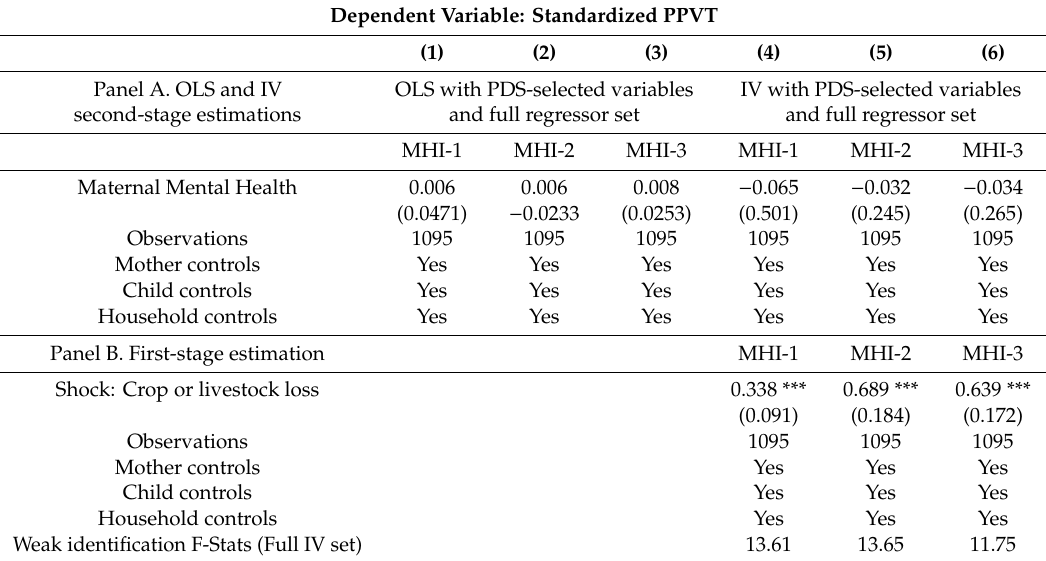
Table 4. E ff ect of maternal mental health on children’s vocabulary at age